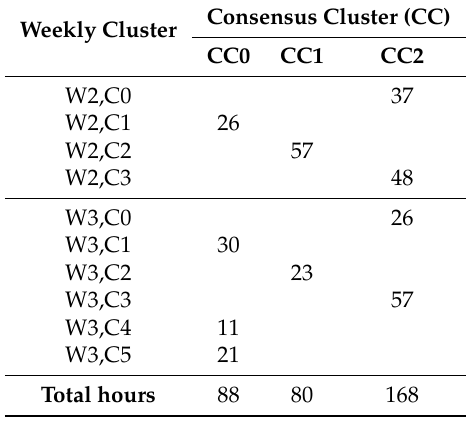
Table 5. Identified hourly deviating behaviours in weeks 2 and 3 for building B_3 in